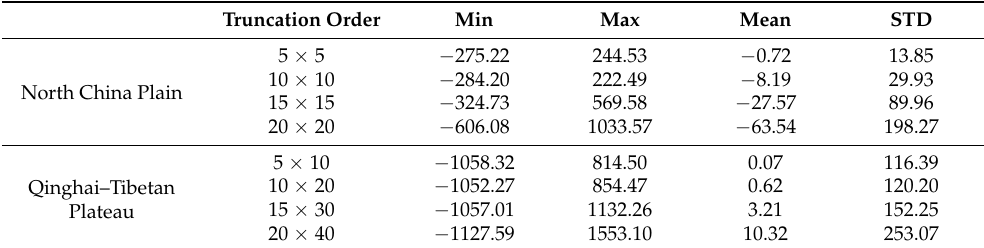
Table 5. The difference between the vertical gravity gradient calculated by the model and that of the UCSD. Unit: E (Eötvös).